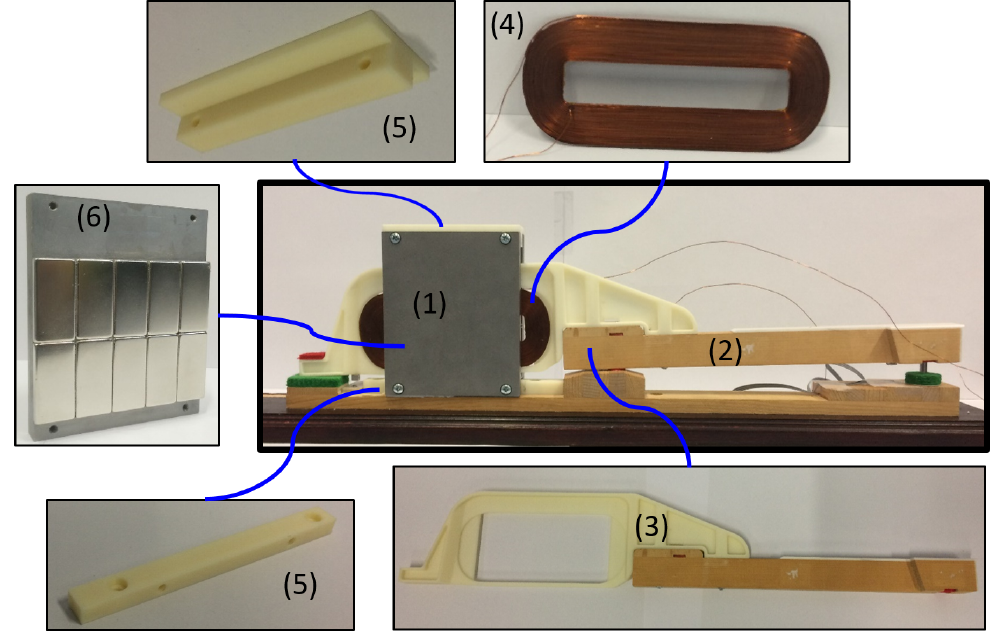
Figure 4. Detailed view of the prototype elements: (1) Actuator; (2) Key; (3) Coil support; (4) Coil; (5) Spacers; (6) Magnets on steel